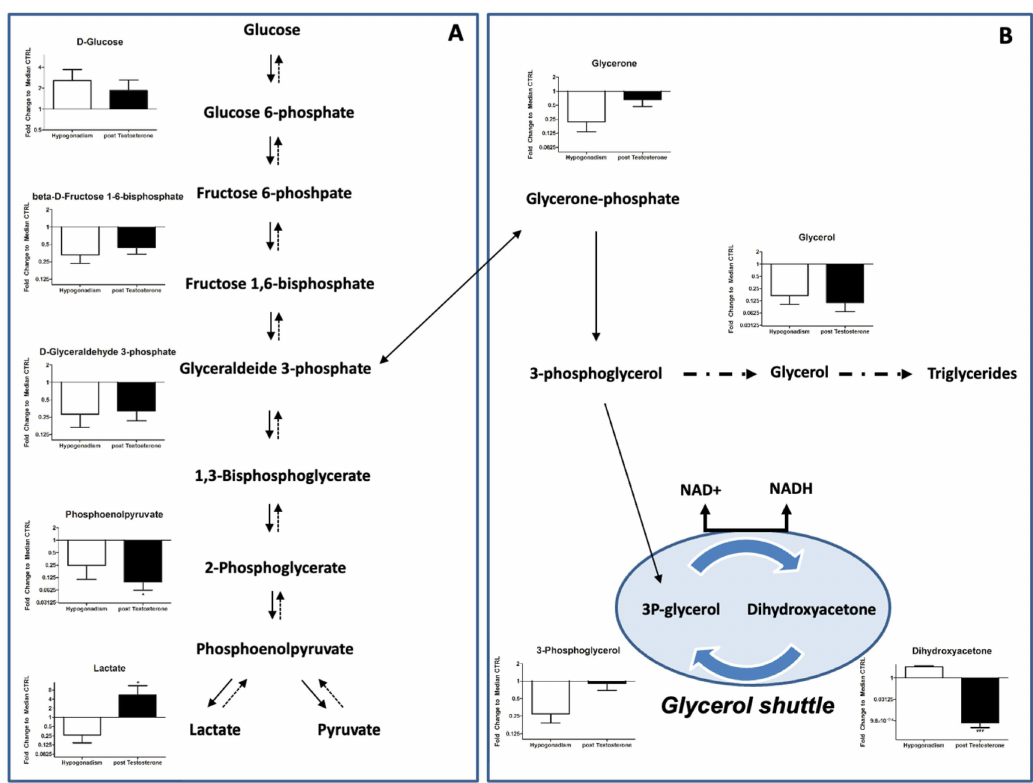
Figure 2. Panel ( A ) Intermediates of glycolysis. The total amount of glycolytic metabolites in the plasma appeared to be slightly restored after testosterone replacement treatment. Panel ( B ) Interme- diates involved in glycerol shuttle and triglyceride synthesis. 3P-glycerol was not converted into glycerol to triglyceride biosynthesis, but it was involved in glycerol shuttle, activating it. All data are shown as mean ± SEM of fold-change relative to the metabolite levels in controls. * p < 0.05, *** p <